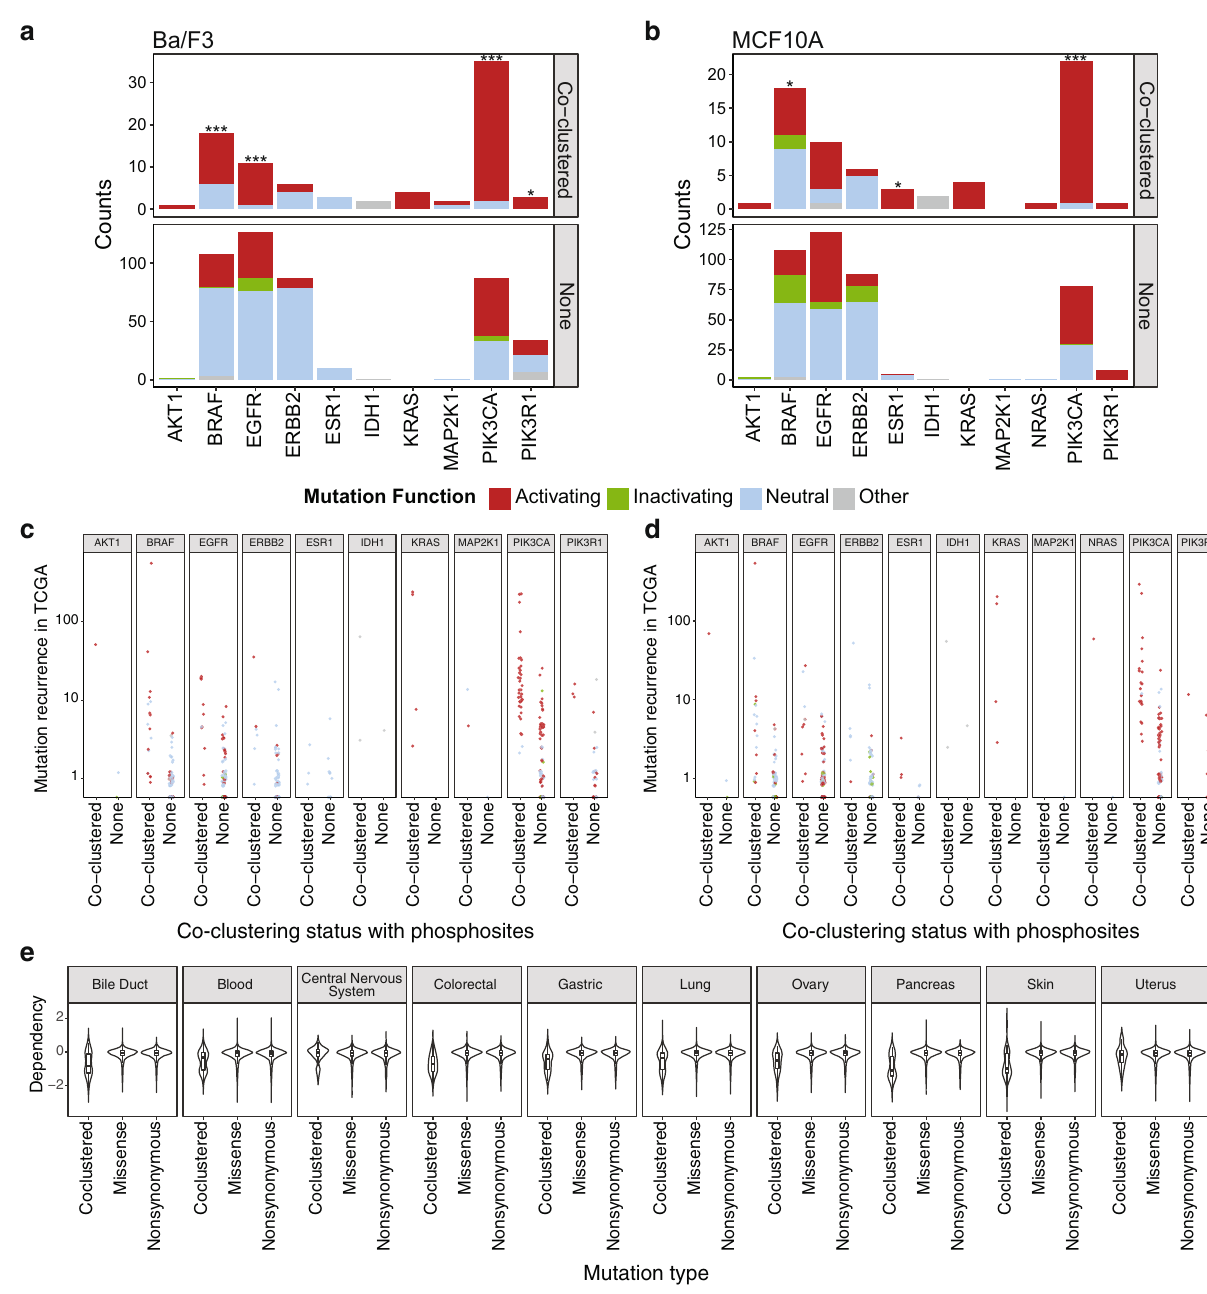
Fig. 5 Functional assessment of co-clustering mutations. Experimental validation data of co-clustering somatic mutations were extracted from previous systematic assessments in a Ba/F3 and b MCF10A cell lines 29 ; we evaluated the functionality of 1054 somatic mutations in a cell viability assay, where each of the evaluated mutations were assessed through one transfected cell colony compared to control cell colonies. The number of activating mutations vs. other types of mutations in each gene was then calculated for the set of co-clustering mutations adjacent to phosphosites as discovered by HotPho and other non-clustering mutations. The asterisk indicates the signi fi cance of the association (One-tailed Fisher ’ s exact test, *** P <0.005, ** 0.005< = p <0.05, * 0.05< = p <0.1). The gene products showing signi fi cant associations include EGFR ( P = 1.63E − 4) and BRAF ( P = 1.11E − 3) co-clustering mutations in Ba/F3, and PIK3CA in Ba/F3 ( P = 1.67E − 5) and MCF10A ( P = 0.0012). At a single mutation level, the functional status (color codes) between co-clustered versus other mutations are further shown for c Ba/F3 and d MCF10A cell lines against the mutation recurrence on the Y -axis, demonstrating the additional predictive power of co-clustering status on mutation functionality. e Dependency CERES score comparison of cell lines with co-clustered vs. other missense vs. other non-synonomous mutations in the DepMap CRISPR screen dataset. The 10 lineages with the highest numbers of co-clustered mutations are shown, including cell lines of the bile duct ( N = 30), blood ( N = 44), central nervous system ( N = 61), colorectal ( N = 36), gastric ( N = 27), lung ( N = 107), ovary ( N = 43), pancreas ( N = 34), skin ( N = 54), and uterus ( N = 26) tissues. The centre line corresponds to the median; lower and upper hinges correspond to the fi rst and third quartiles (the 25th and 75th percentiles), respectively; the whiskers extend from the hinges to the largest value no further than 1.5 * IQR from the respective hinge, where IQR (inter-quartile range) is the distance between the fi rst and third